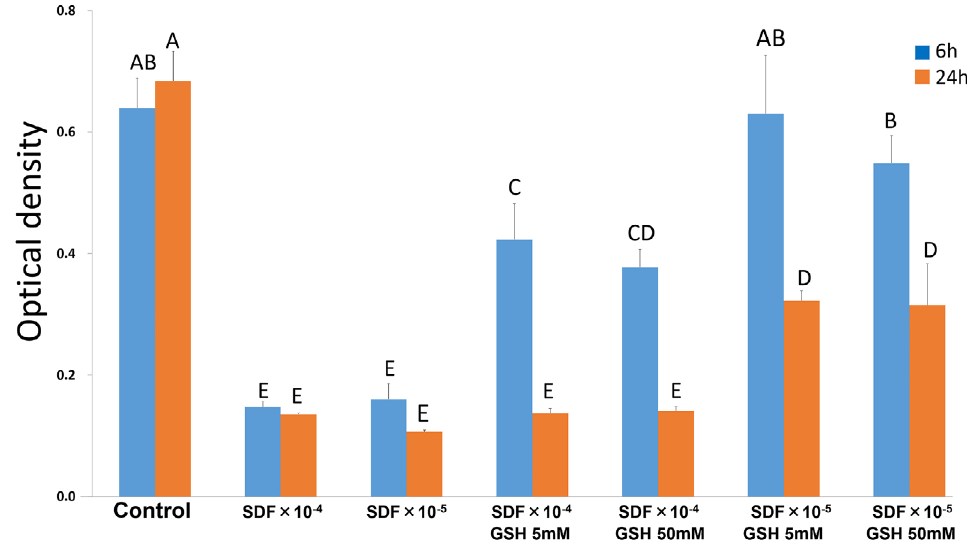
Figure 1- Cytotoxicity of culture medium on RPC-C2A cells containing diluted SDF with and without GSH after 6 and 24 h of incubation. Cell viability was determined by using WST-8 assay. Data were analysed by using two-way ANOVA. The same letter indicates no significant differ-ence (P>.05)